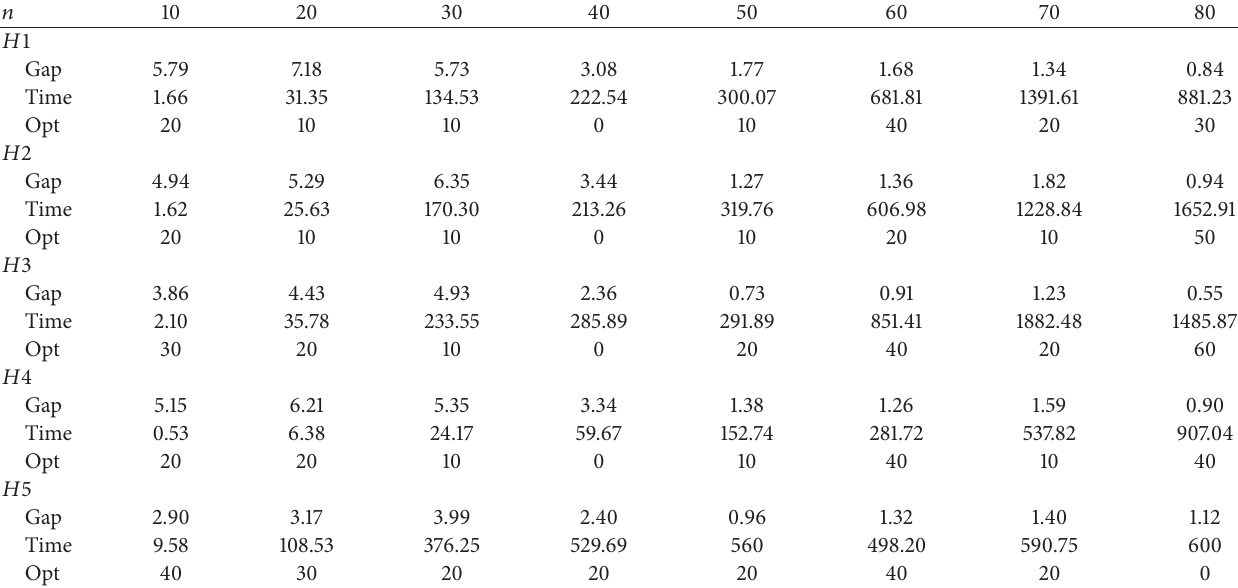
Table 14: Performance of the heuristics for 𝑚 =